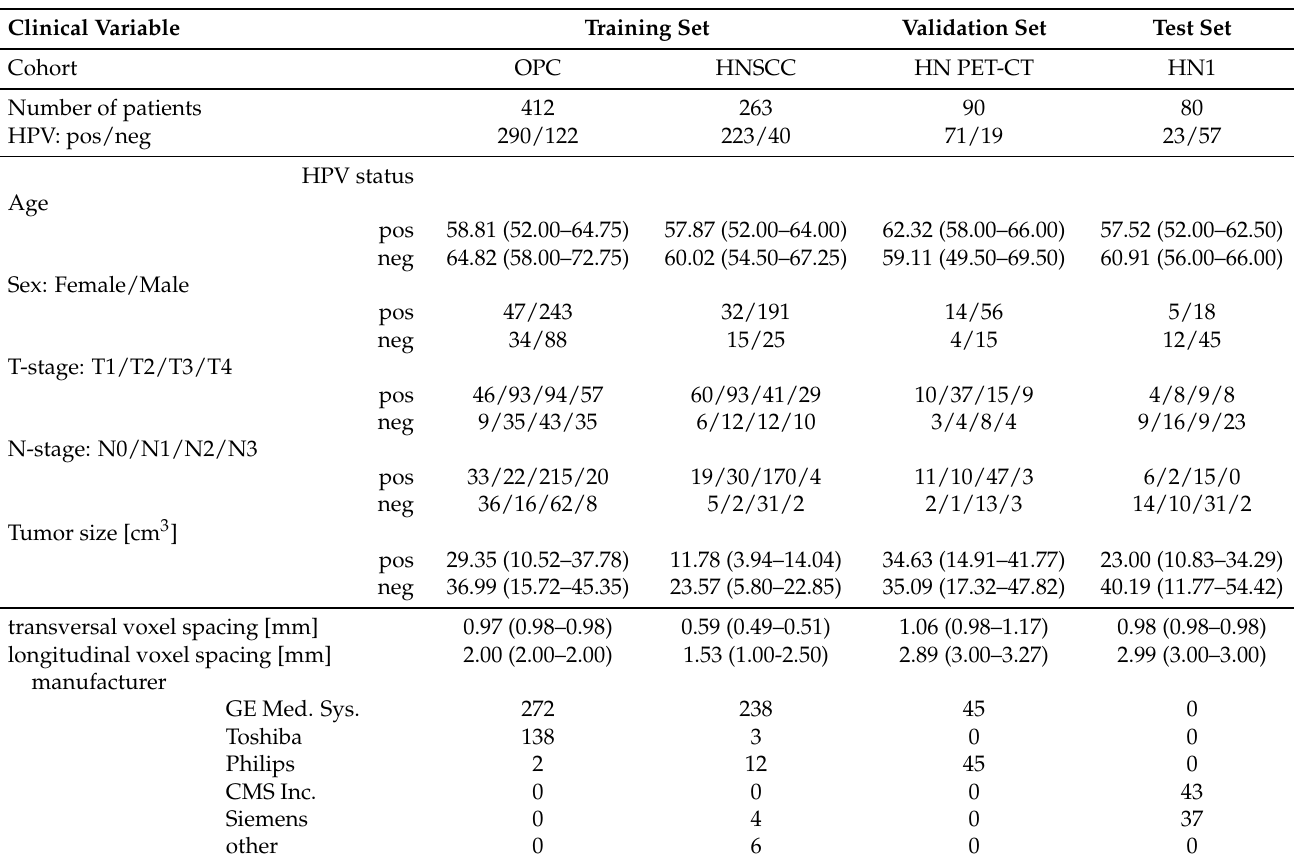
Table 1. Patient information for the different cohorts. Continuous variables are represented by mean values and ranges by ( q 25 – q 75 ), with q 25 and q 75 being the 25th and 75th percentiles,